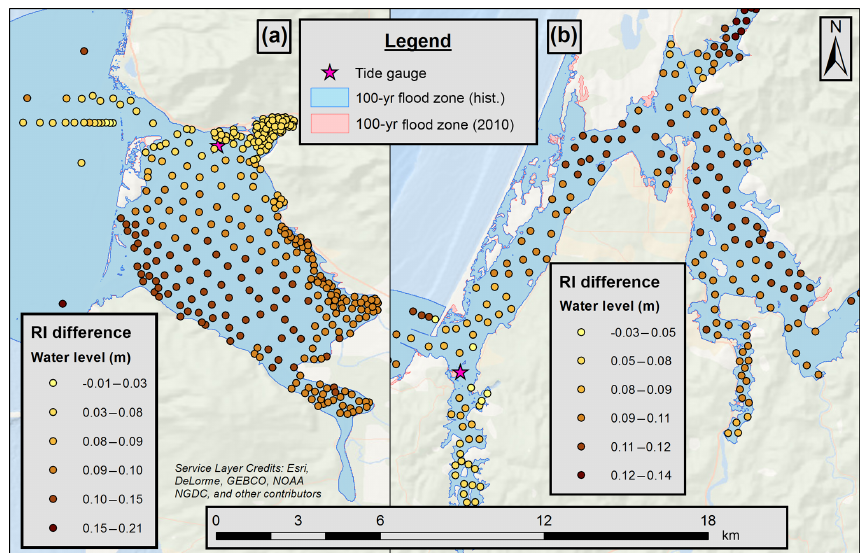
Figure 8. Changes to 100-year RIs plotted at output stations. Changes are calculated as the future effective RI WL (at year 2050, 0.172m of SLR) minus the historic RI WL. The blue surface is the calculated historic 100-year floodplain while the red surface is the future 100-year flood surface calculated for the year